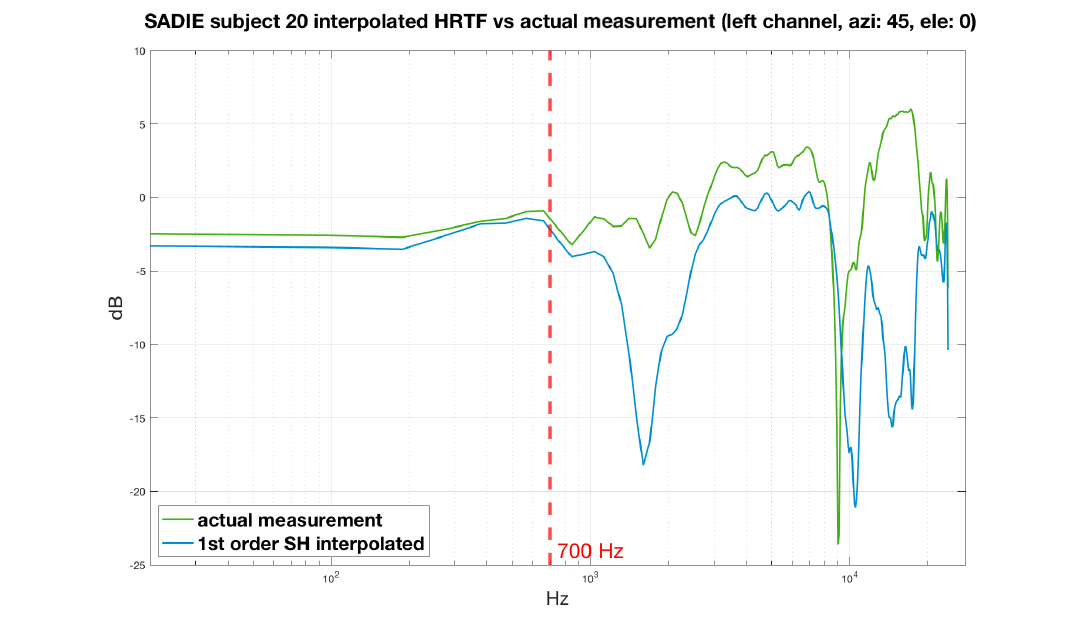
Figure 2. Actual ipsilateral HRTF measurement vs. SH-interpolated HRTF (green: Actual HRTF measurement, blue: SH-interpolated HRTF), M =